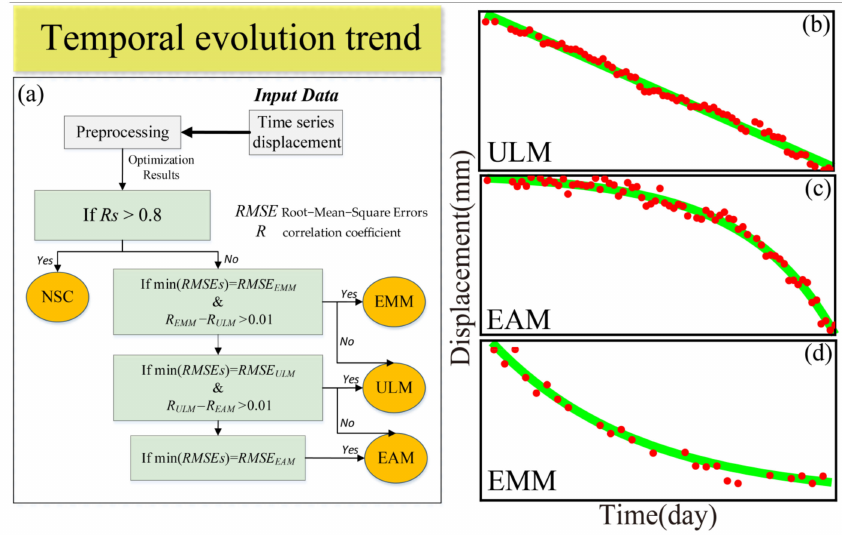
Figure 4. The ( a ) flowchart of temporal evolution trend estimation and ( b – d ) classification examples of ULM, EAM and EMM.